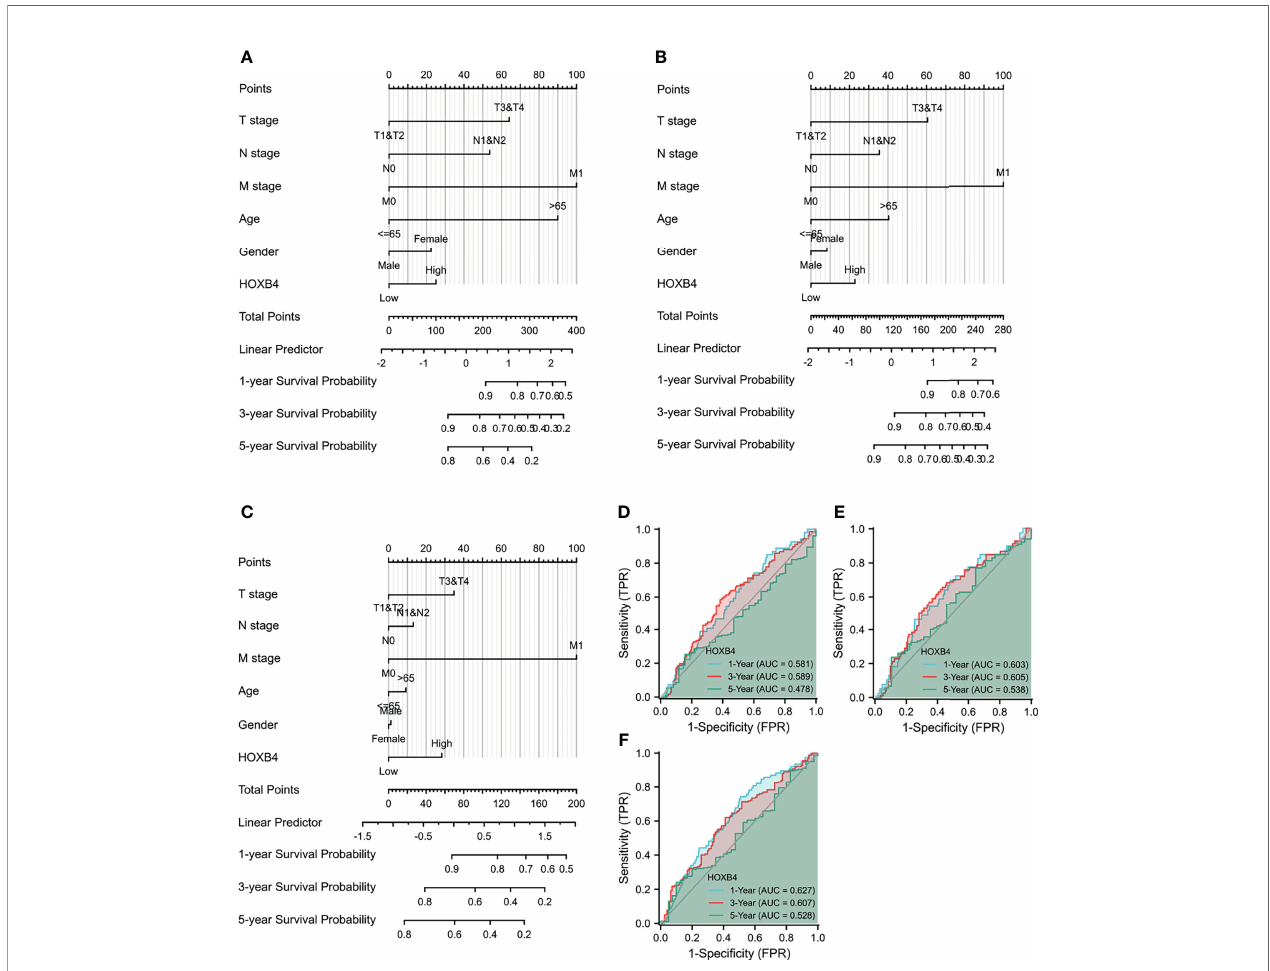
FIGURE 5 | Evaluation of nomogram and receiver operating characteristic curves (ROC) analysis. (A – C) The nomogram analysis of HOXB4 TPM value, T stage, N stage, M stage, age, and gender. The total points projected on the bottom scales implied the probability of 1-, 3-, and 5-year OS event, DFS event, and PFI event. (D – F) ROC curves for the predictive ef fi ciency of the HOXB4 for COAD patients based on TCGA cohorts. OS, overall survival; DFS, disease-speci fi c survival; PFI, progression free interval; COAD, colon